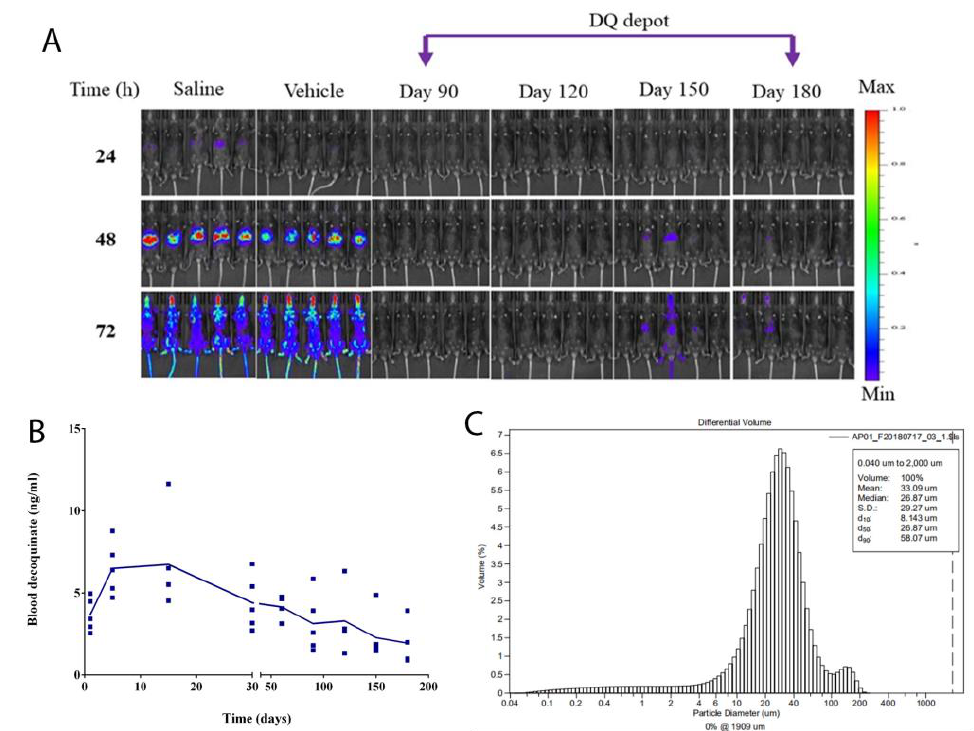
Figure 4. Duration of malaria prophylaxis provided by SRFD in mice with Plasmodium infection. HME extrudates (F2) were suspended in saline and given to separate groups of mice (C57) at a dose of DQ 200 mg/kg by IM. After SRFD replacement, mice were, respectively, inoculated with Plasmodium berghei SPZ at different time lengths. New mice for saline and vehicle controls were replaced and matched with experimental mice in each group. ( A ) Images shown are from experimental groups with the SPZ inoculation on days 90, 120, 150, and 180. Images from the early time points before 90 days are not shown. Mice were monitored by IVIS 24, 48, and 72 h after SPZ injection. At 24 and 48 h, the signals if any were localized in the abdominal area (liver) and then spread to the whole body at 72 h or after 48 h. ( B ) Parallel experiments were performed in the same kind of animals (C57) as the mice in ( A ). The same SRFD (F2) was administered at a dose of DQ 200 mg/kg by IM to the mice. Blood samples were drawn at different days by cardiac puncture and the blood concentrations of DQ were measured by LC-MS. ( C ) Mean particle size of HME extrudates (F2). Table 2. Chemoprophylaxis of DQ in C57 black mice infected with Plasmodium berghei ( P.b. ).